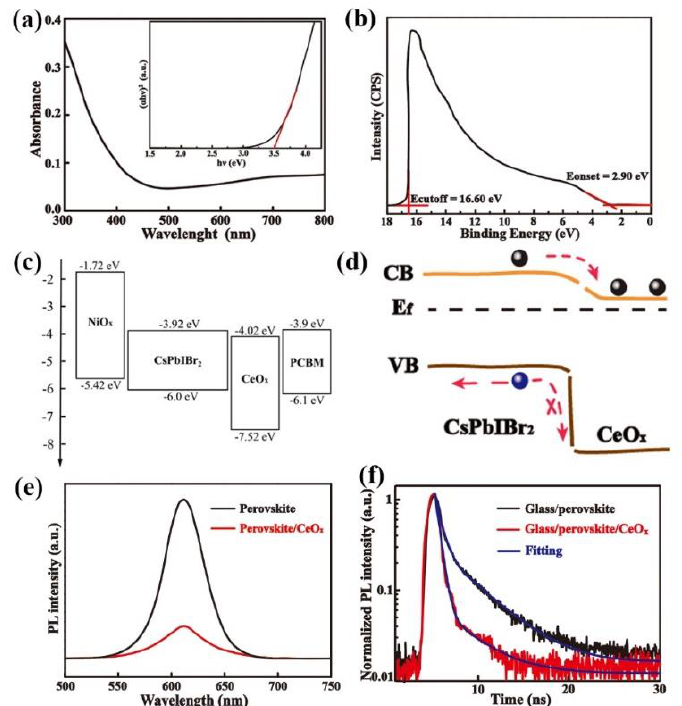
Figure 3. ( a ) UV-vis absorption spectra of CeO x film. (The inset is plots of the ( α h ν ) 2 versus energy). ( b ) UPS spectra of the CeOx film. ( c ) The energy band diagram of the components in the device. ( d ) the diagram of energy bands bends downwards at the CsPbIBr 2 / CeO x interface. ( e ) The steady-state photoluminescence (PL) spectra. ( f ) The time-resolved PL spectra.